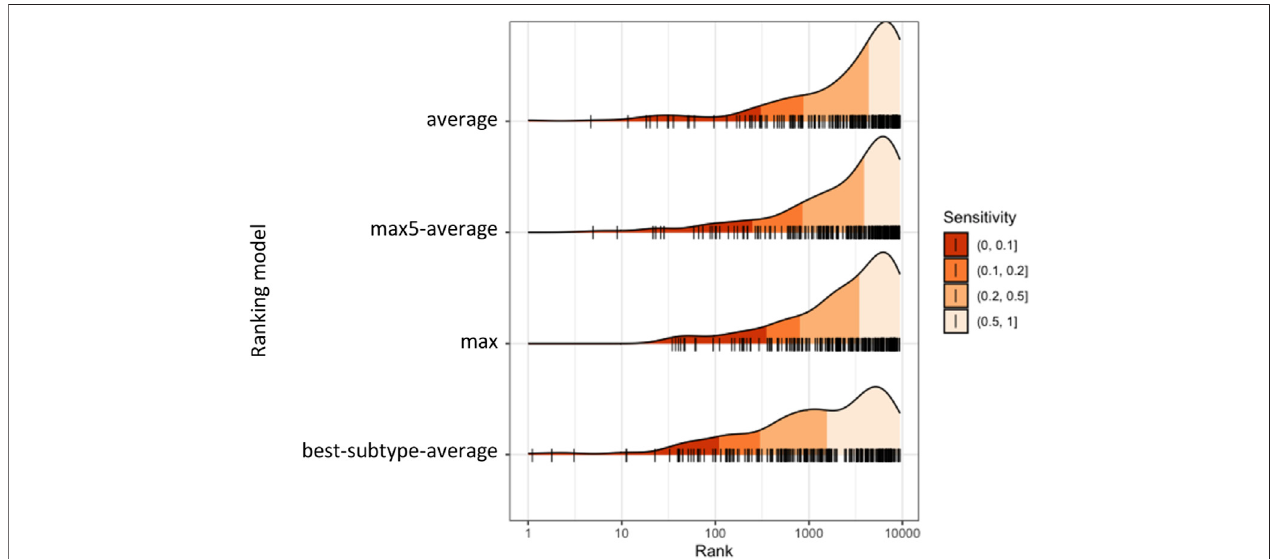
FIGURE 5 | Distribution of ranks of diagnosed ciliopathy cases obtained from different ranking models.